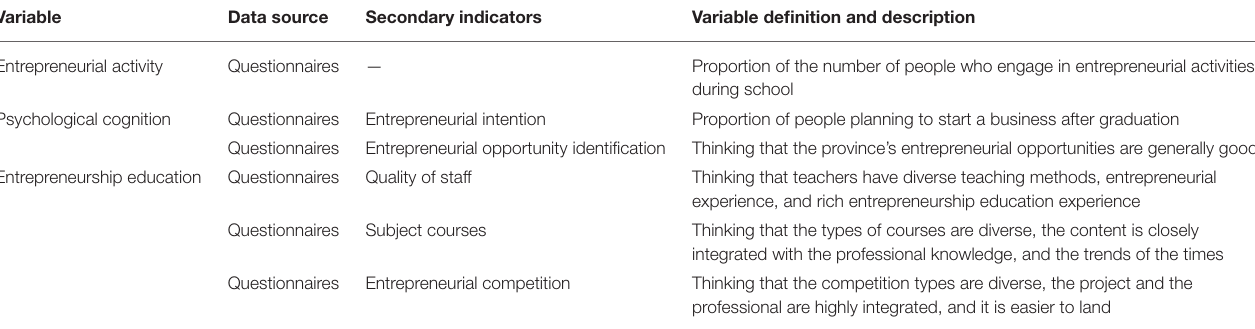
TABLE 1 | Variable selection and assignment.